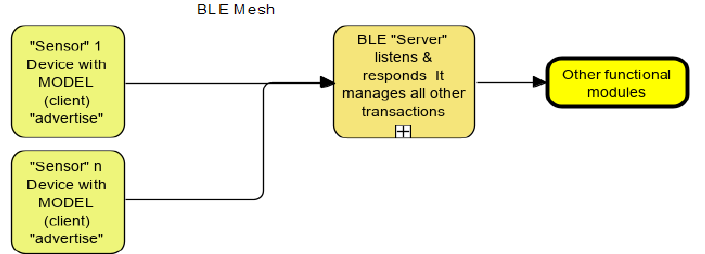
Figure 9. Typical machine learning BLE mesh architecture delivering “intelligence at the edge”.